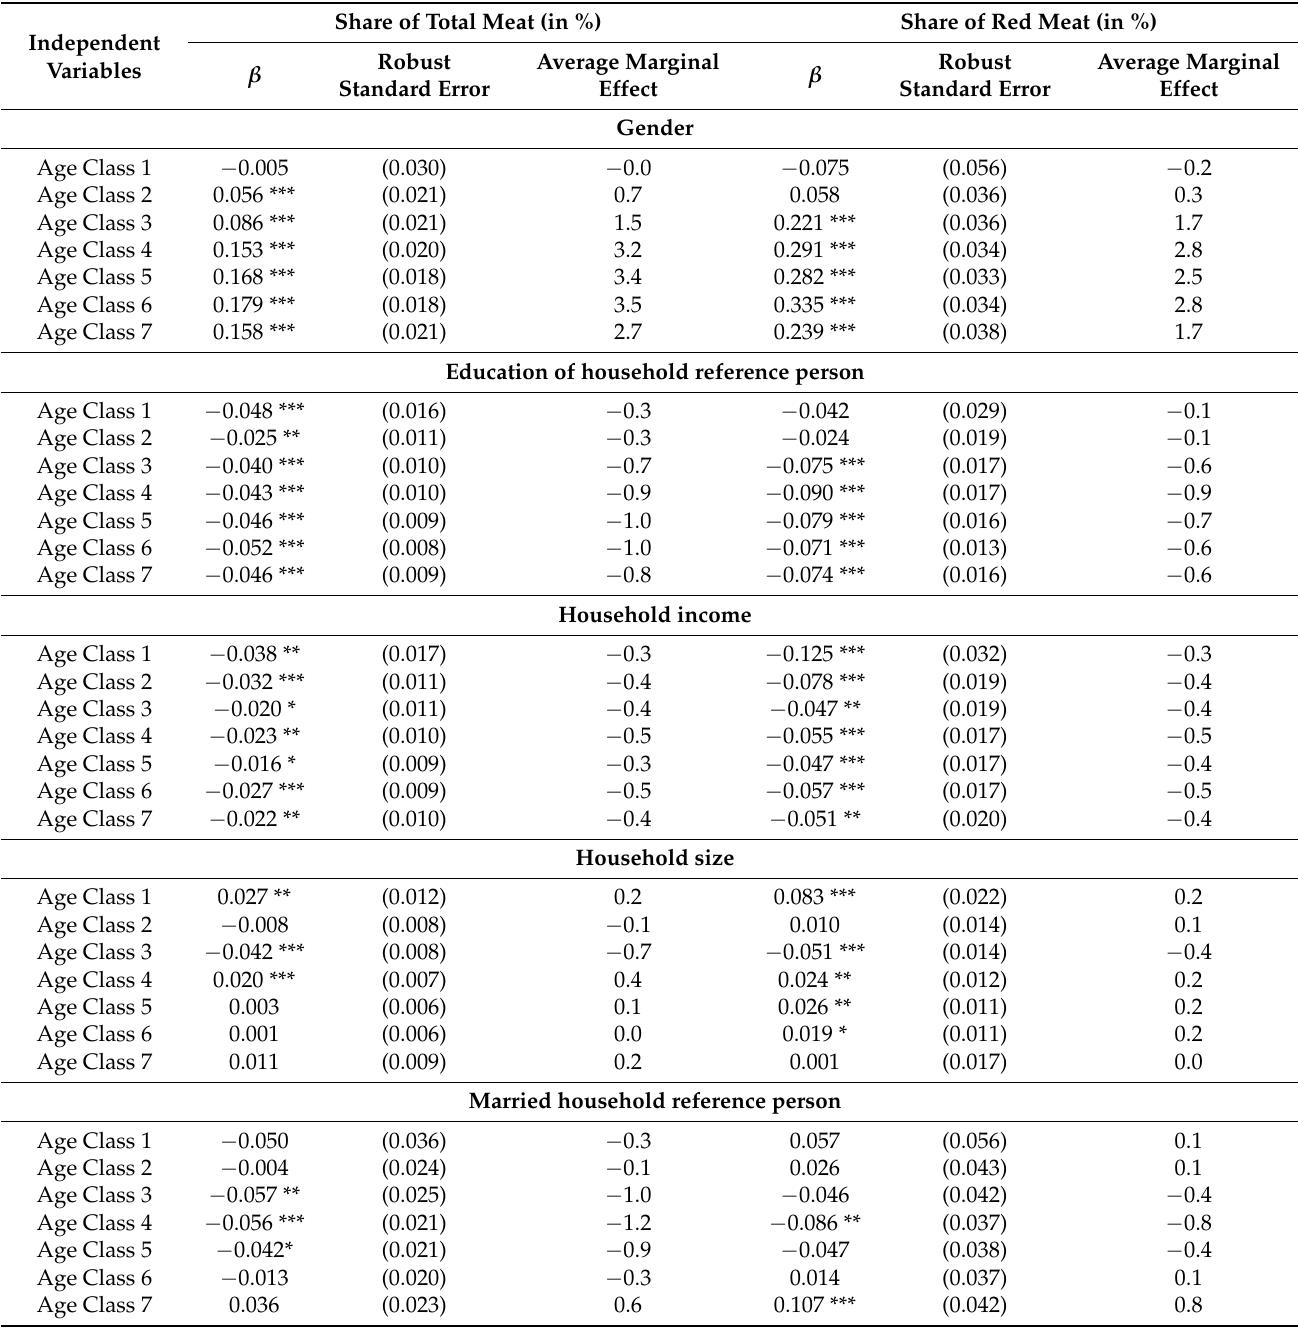
Table 4. Results of the multiple-group regression for the two dependent variables: (1) share of total meat consumption (in %) and (2) share of red meat consumption (in